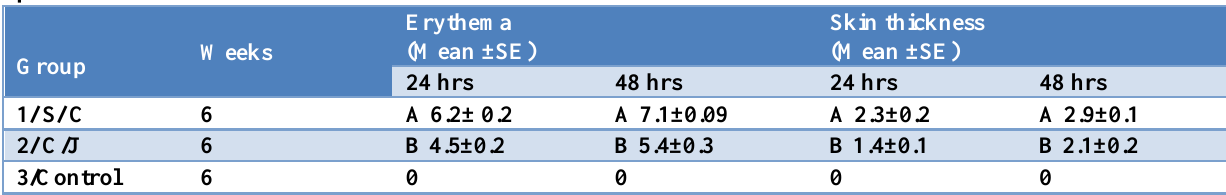
Table, 2: Mean of skin thickness and standard error of goats inoculated with brucellin at 6 th week post-vaccination